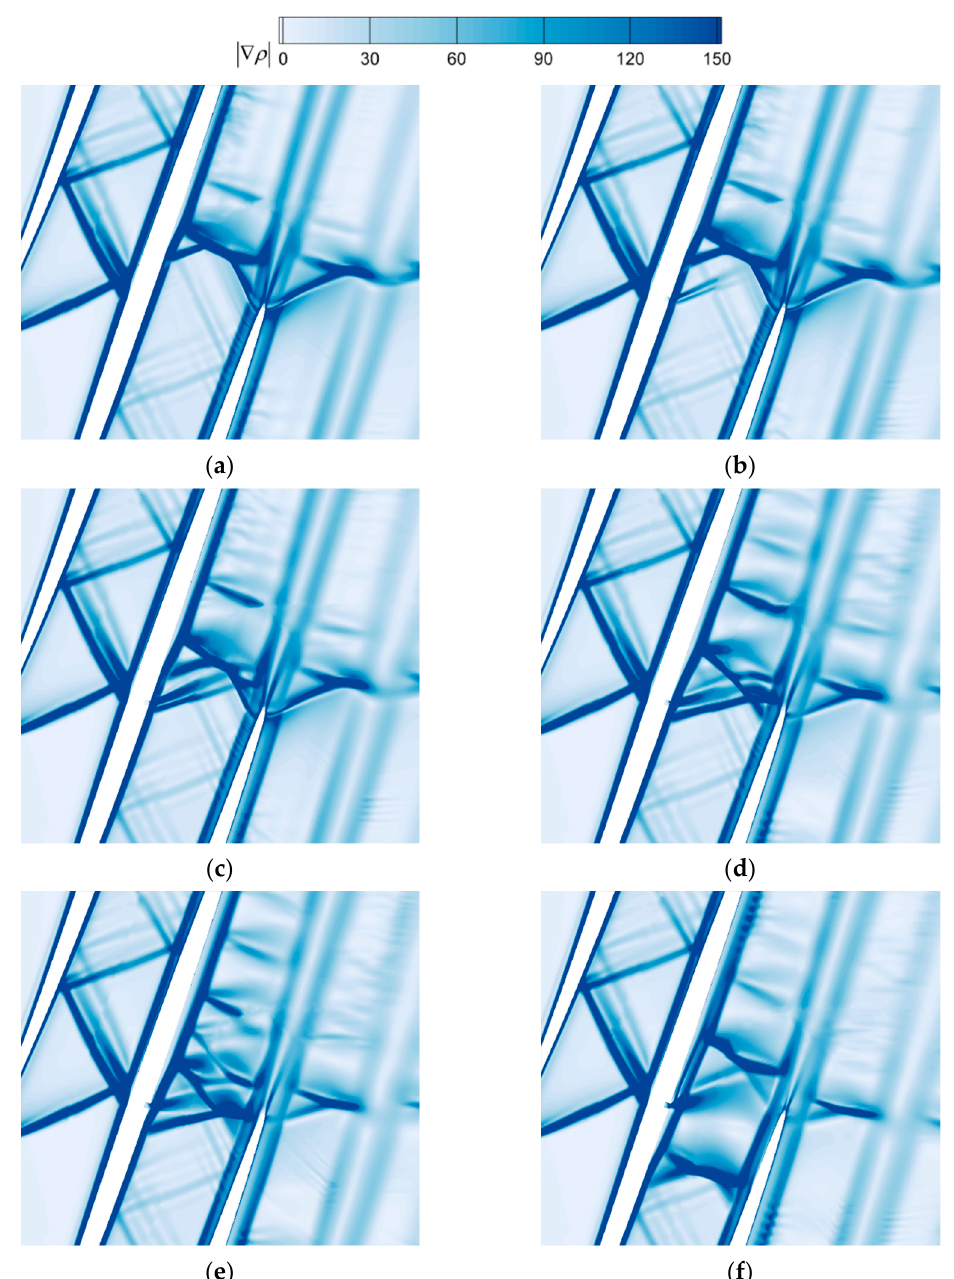
Figure 9. Density gradient magnitude contours with different strength of jet : ( a ) baseline; ( b ) 𝑝 (cid:3037)∗ = 130 kPa ; ( c ) 𝑝 (cid:3037)∗ = 145 kPa ; ( d ) 𝑝 (cid:3037)∗ = 165 kPa ; ( e ) 𝑝 (cid:3037)∗ = 175 kPa ; ( f ) 𝑝 (cid:3037)∗ = 210 kPa .